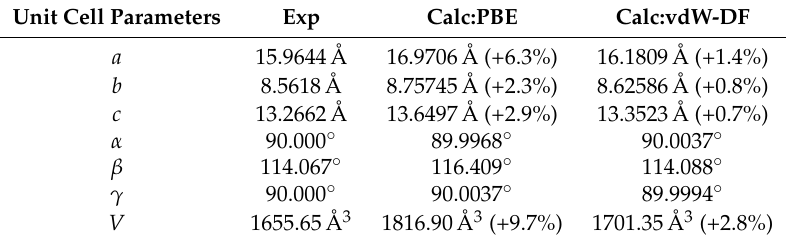
Table 1. Unit cell parameters of κ -CuCN obtained from X-ray diffraction measurements at 100K (left column), ab initio calculations based solely on PBE functional (central column) and on vdW-DF functional (right column). Relative deviations from experimental values are given in parentheses.